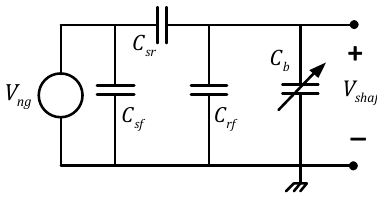
Figure 4. Electrical model of stray capacitances.